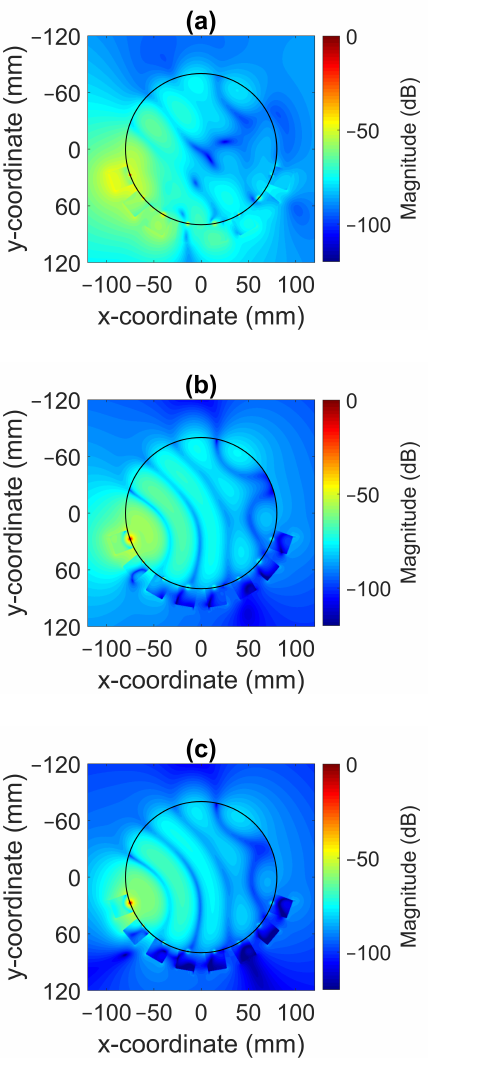
Figure 8. Simulated radiation patterns for a monopole antenna surrounded by coupling gels in contact with a muscle phantom for different conductivity values at 0.7 GHz (( a ) Gel #1; ( b ) Gel #2; ( c ) Gel #3) and at 1.65 GHz (( d ) Gel #1; ( e ) Gel #2; ( f ) Gel